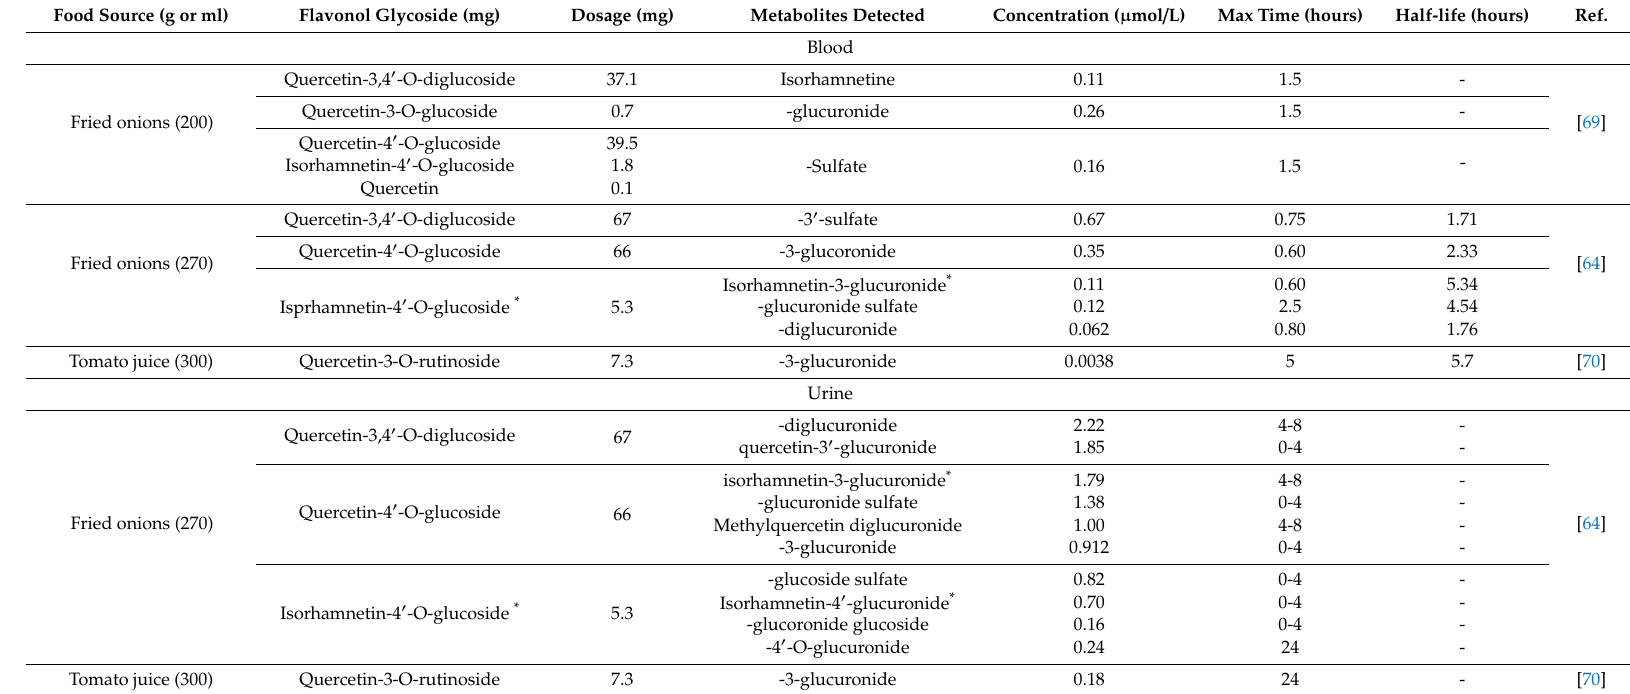
Table 4. Major quercetin metabolites in blood and urine after the ingestion of quercetin-rich